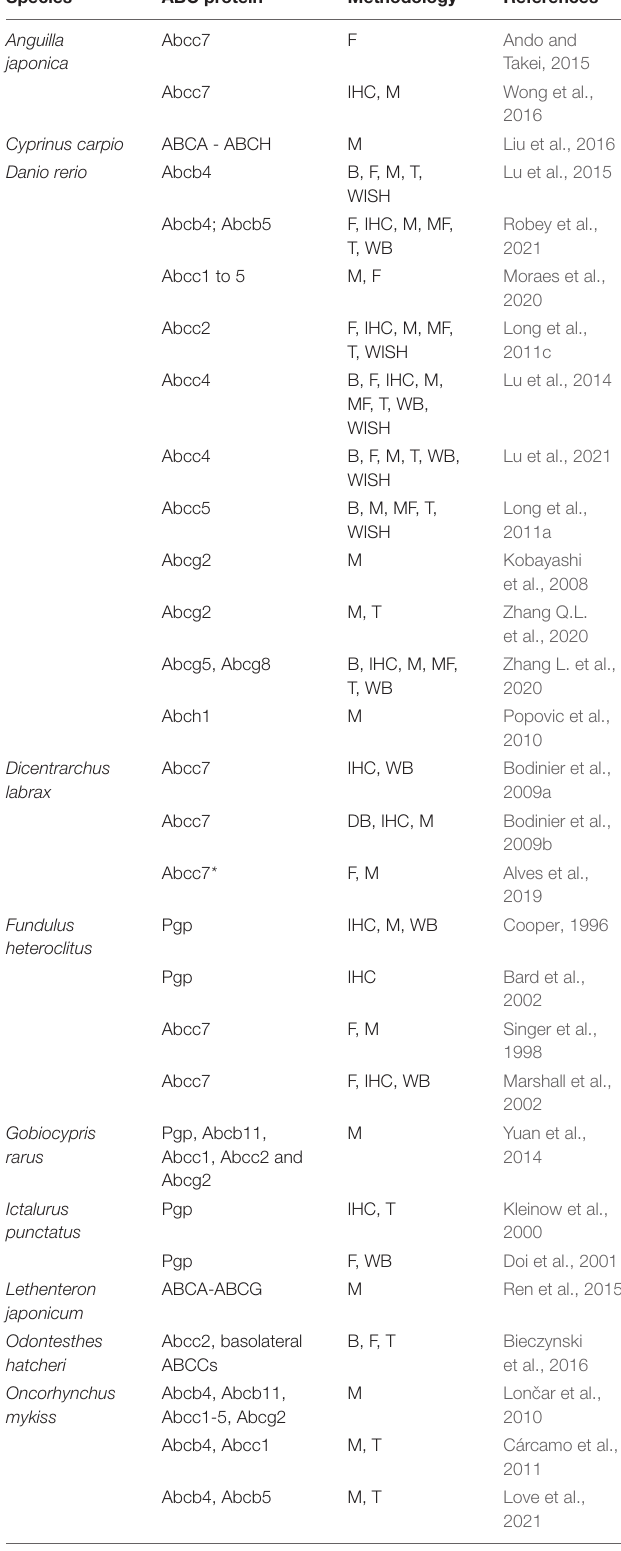
TABLE 1 | Studies on fish intestine ABC